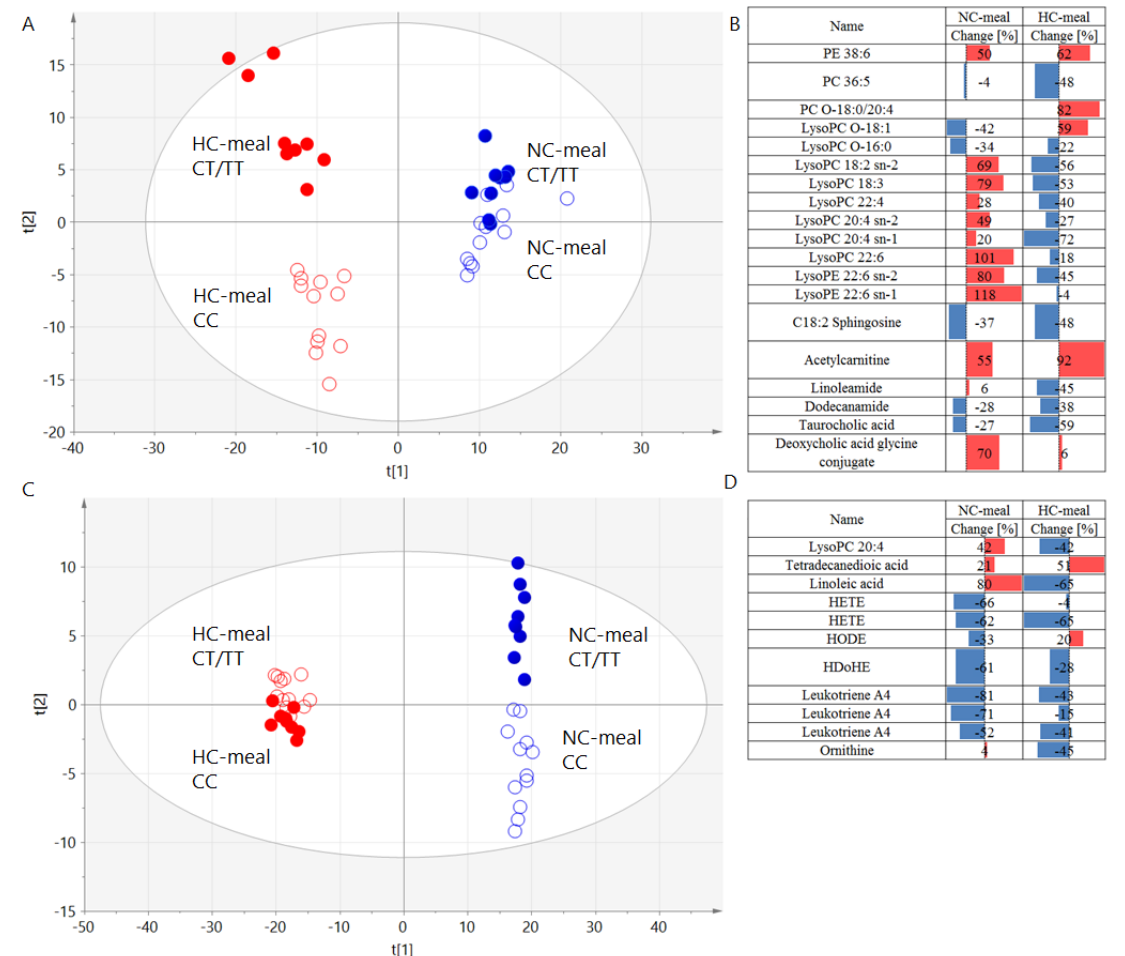
Figure 3. PLS-DA models computed based on AUCs of plasma metabolites illustrating clear separation between men carrying CC (empty dots) and CT / TT (full dots) genotypes after NC- (blue color) and HC-meal (red color) for ESI + (panel A ) and ESI- (panel C ) with the summary of the di ff erentiating signals and their change in ESI + (panel B ) and ESI- (panel D ). The parameters of the models: R2 = 0.581, Q2 = 0.318 for ESI + ; R2 = 0.594, Q2 = 0.0.264 for ESI-. R2 = explained variance, Q = predictive capability of the model.